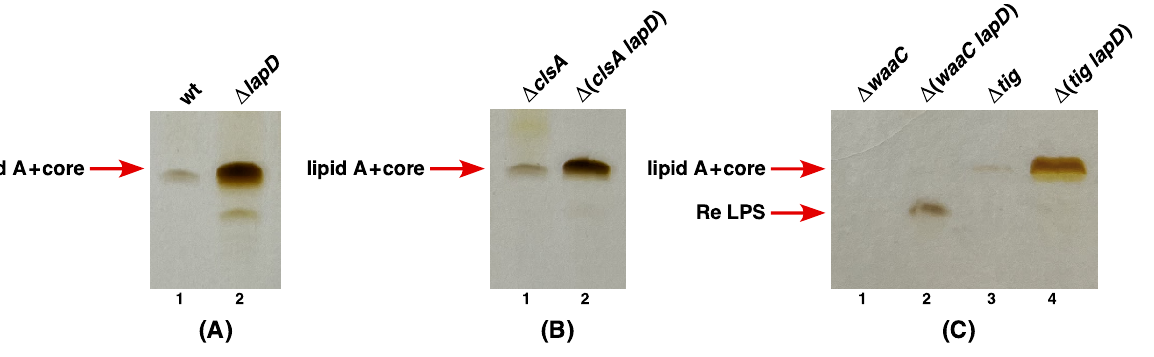
Figure 10. Lack of LapD causes the retention of significant amounts of LPS in the inner membrane. Total cell lysates obtained from isogenic derivatives of wild-type and ∆ lapD bacteria were subjected to cellular fractionation to obtain the IM. Samples were treated with Proteinase K and resolved on a 16% Tricine-SDS gel. LPS was revealed by silver staining. The position of the LPS species is indicated by the arrow. Note the intense bands of LPS in the IM fraction of ∆ lapD and its derivatives wt vs. ∆ lapD ( A ), ∆ clsA vs. ∆ ( clsA lapD ) ( B ) and ∆ waaC , ∆ ( waaC lapD ), ∆ tig , ∆ ( tig lapD ) ( C ). The relevant genotype of strains used is indicated on the top of each panel.